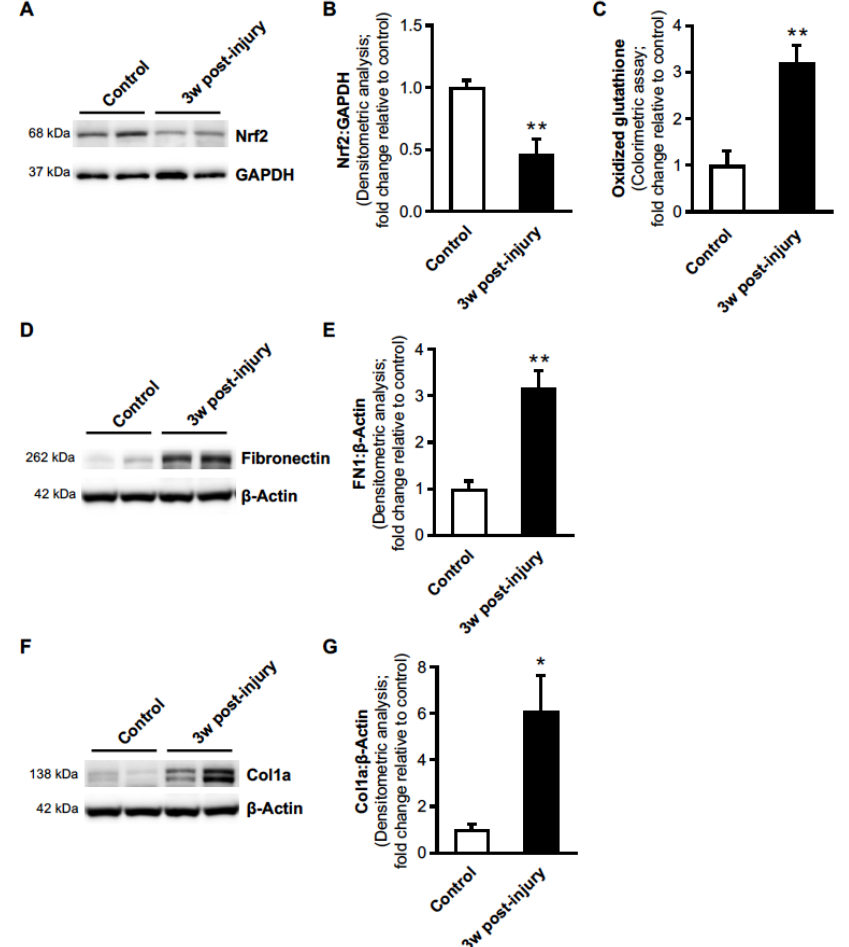
Figure 2. Aged-injured mice exhibit Nrf2 deficiency associated with oxidative stress and lung fibrosis. ( A , B ) Lung protein was assessed for Nrf2 expression by Western blot ( A ) and densitometric analysis ( B ). ( C ) The level of lung oxidized glutathione was analyzed by quantitative oxidized glutathione assay. ( D – G ) Lung protein was assessed for fibronectin ( D , E ) and collagen-1 α (Col-1 α ) ( F , G ) expression by Western blot and densitometric analysis. Representative Western blot images are shown. All values represent means of biological replicates ± SEM; n = 4 mice per group; * p < 0.05; ** p < 0.01 using Student’s two -tailed t -test.